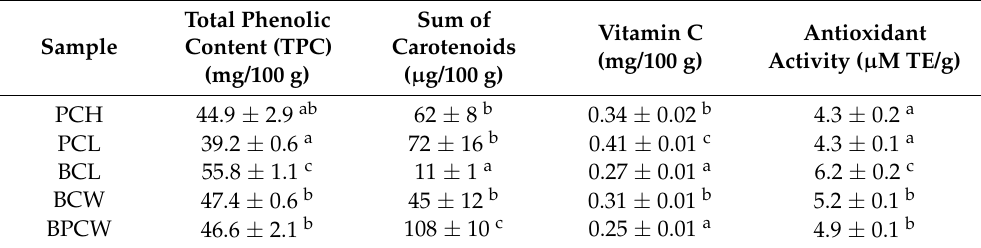
Table 2. Total phenolic content, carotenoids, vitamin C content, and antioxidant activity of different